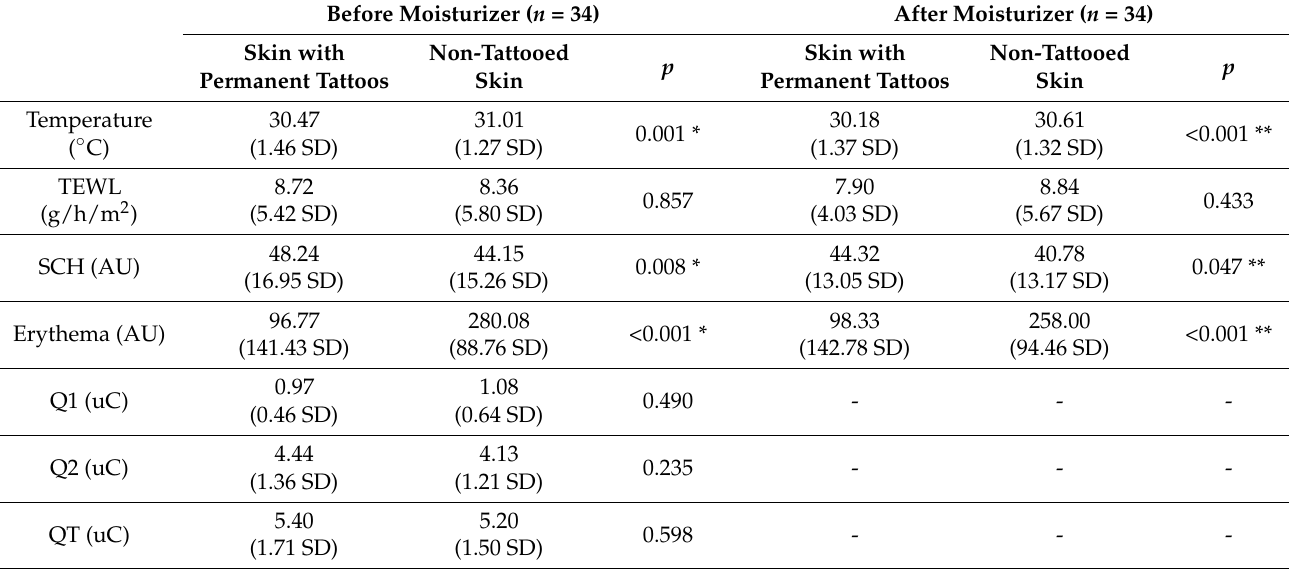
Table 2. Differences in biophysical parameters between skin with permanent tattoos and non-tattooed skin. Before Moisturizer ( n = 34) After Moisturizer ( n = 34) Skin with Skin with Non-Tattooed p Permanent Tattoos Permanent Tattoos Skin